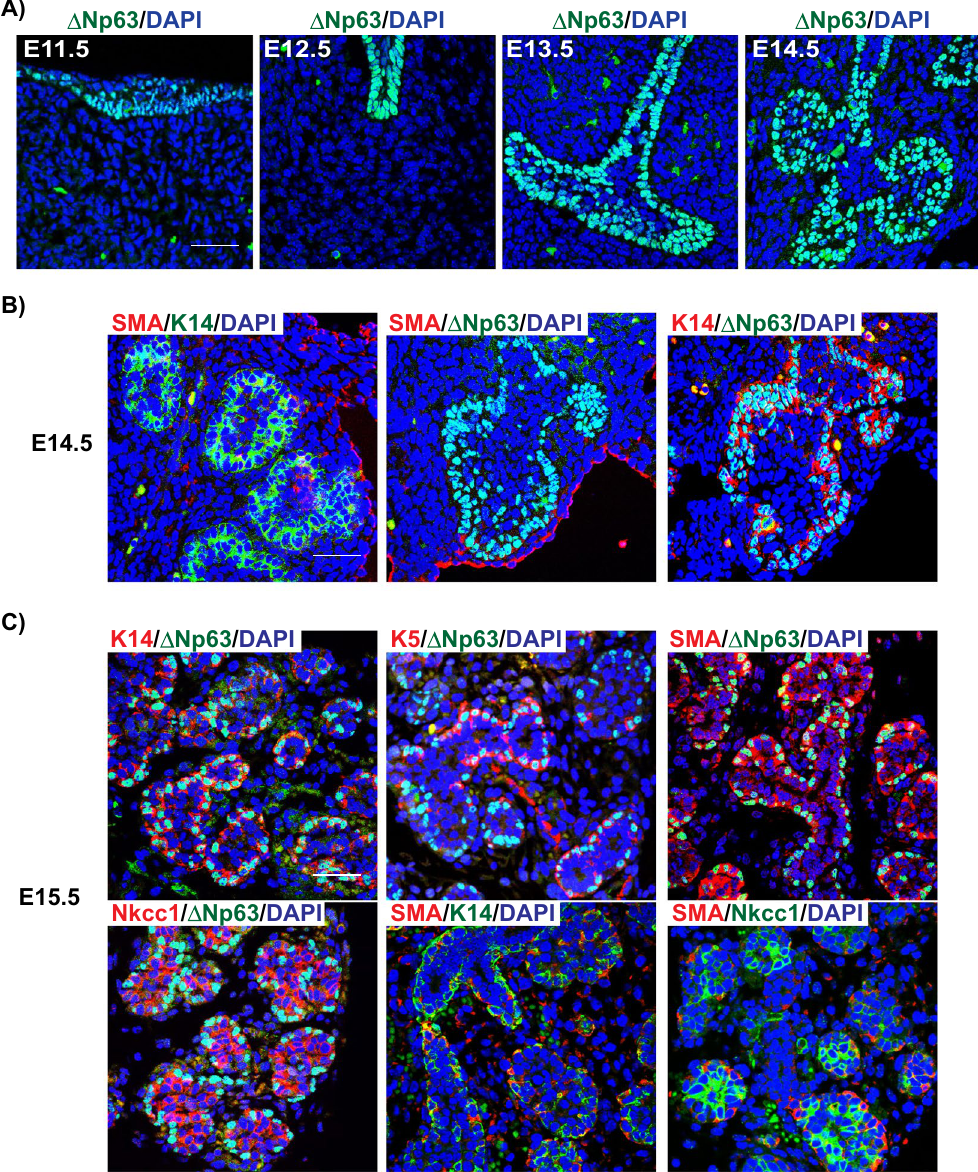
Figure 2. Spatial expression pattern of Δ Np63 and SMA proteins during the early stages of salivary gland morphogenesis. ( A ) Δ Np63 is expressed in the epithelial cells of the placode as well as the developing buds and end buds during the early stages of salivary gland development. ( B ) Expression of the basal and myoepithelial cell markers SMA, K14 and Δ Np63 at E14.5. ( C ) At E15.5 Δ Np63 and SMA expression is observed in the basal and myoepithelial cells surrounding the developing ducts and acini. Scale bar 37 μ